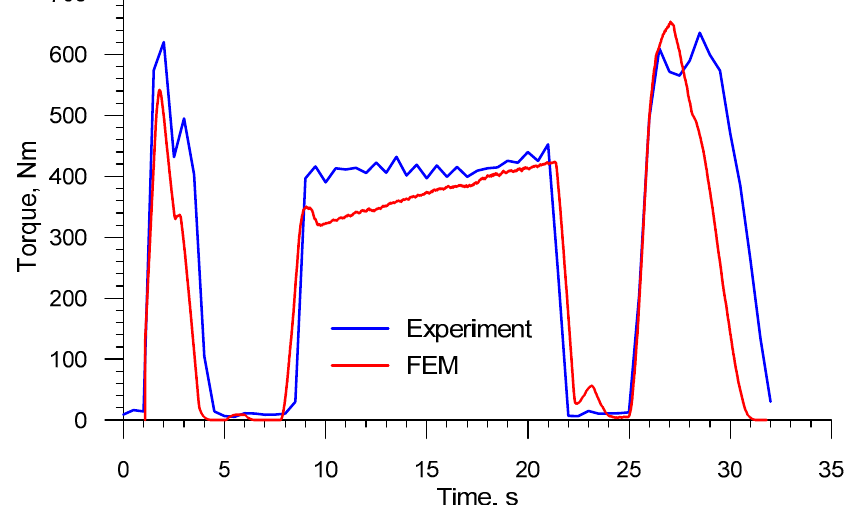
Figure 28. Comparison of the FEM and experimental torques in skew rolling railway axles in a 3-roll mill (1:5 scale).